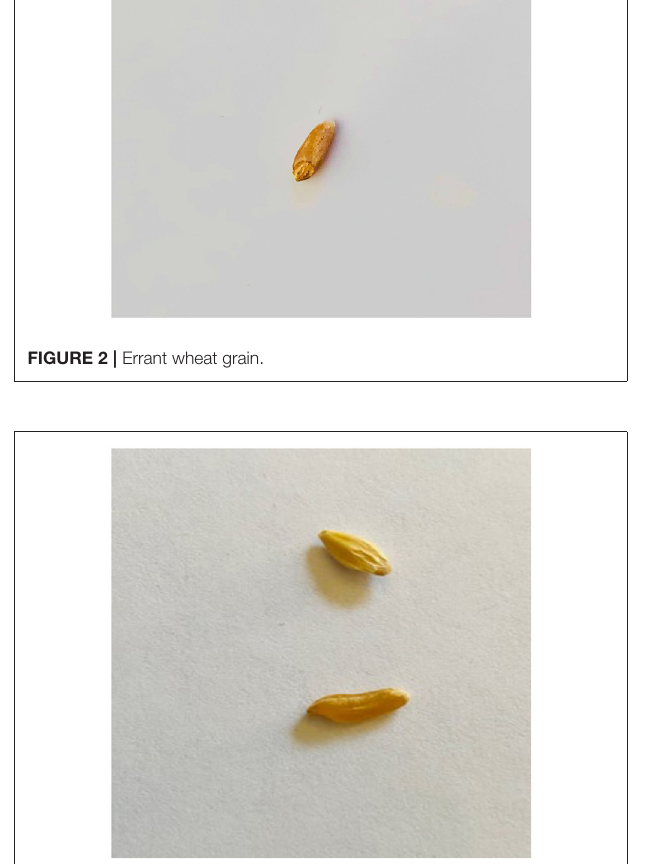
FIGURE 3 | Errant wheat and barley